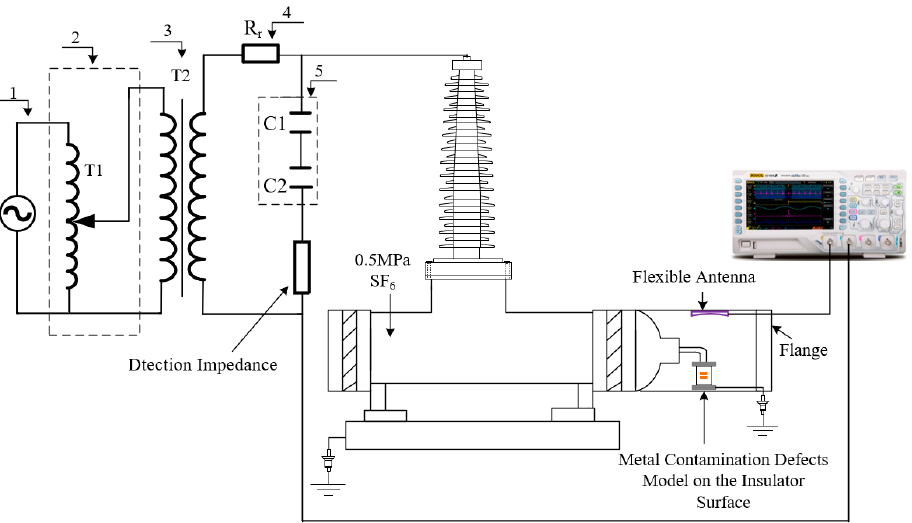
Figure 17. Spectrum Analysis Diagram: ( a ) Electromagnetic Noise Spectrum; ( b ) Spectrum of PD Signals Detected by Antennas with Different Bending Degrees;.